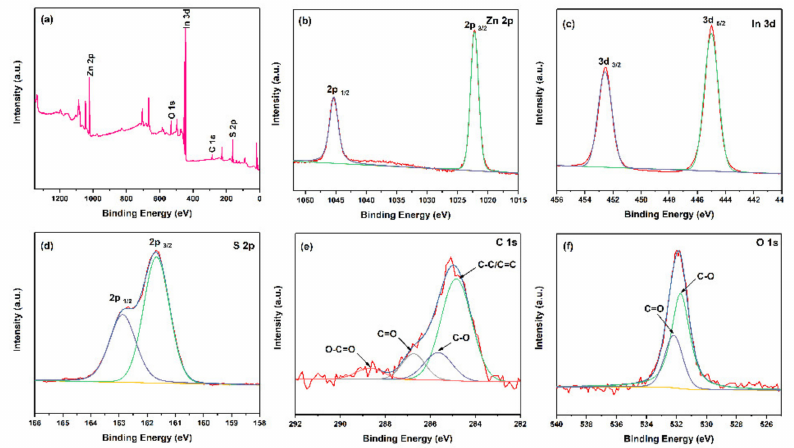
Figure 3. XPS spectra of the GO / ZIS-1. ( a ) Survey of the sample, ( b ) Zn 2p, ( c ) In 3d, ( d ) S 2p, ( e ) C 1s, ( f ) O